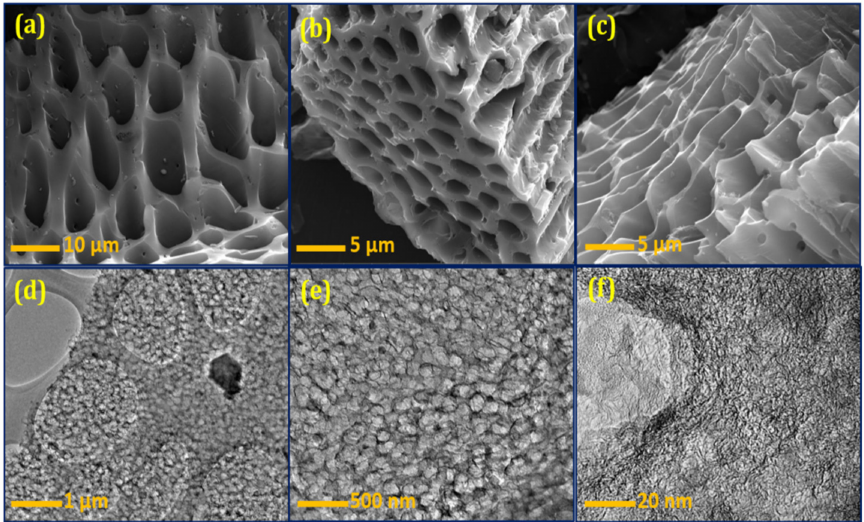
Figure 3. ( a – c ) FESEM and ( d – f ) HRTEM images of the BSPC at different